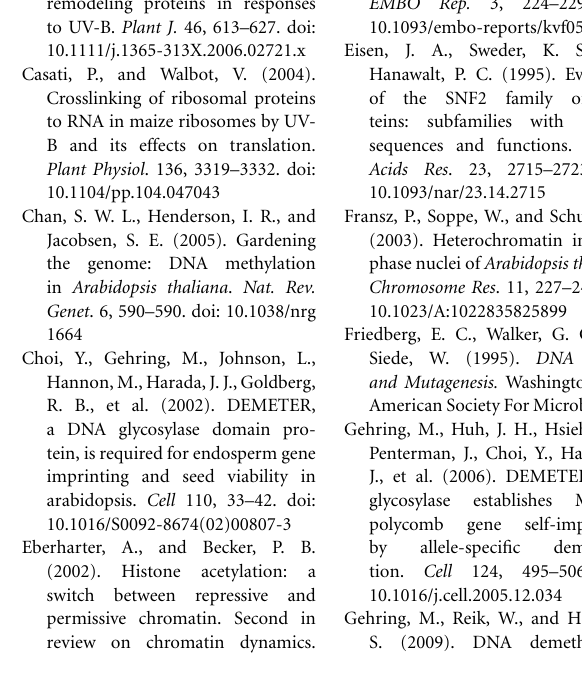
Figure S4 | Expression of DDM1 transcripts in Col0 plants and ddm1